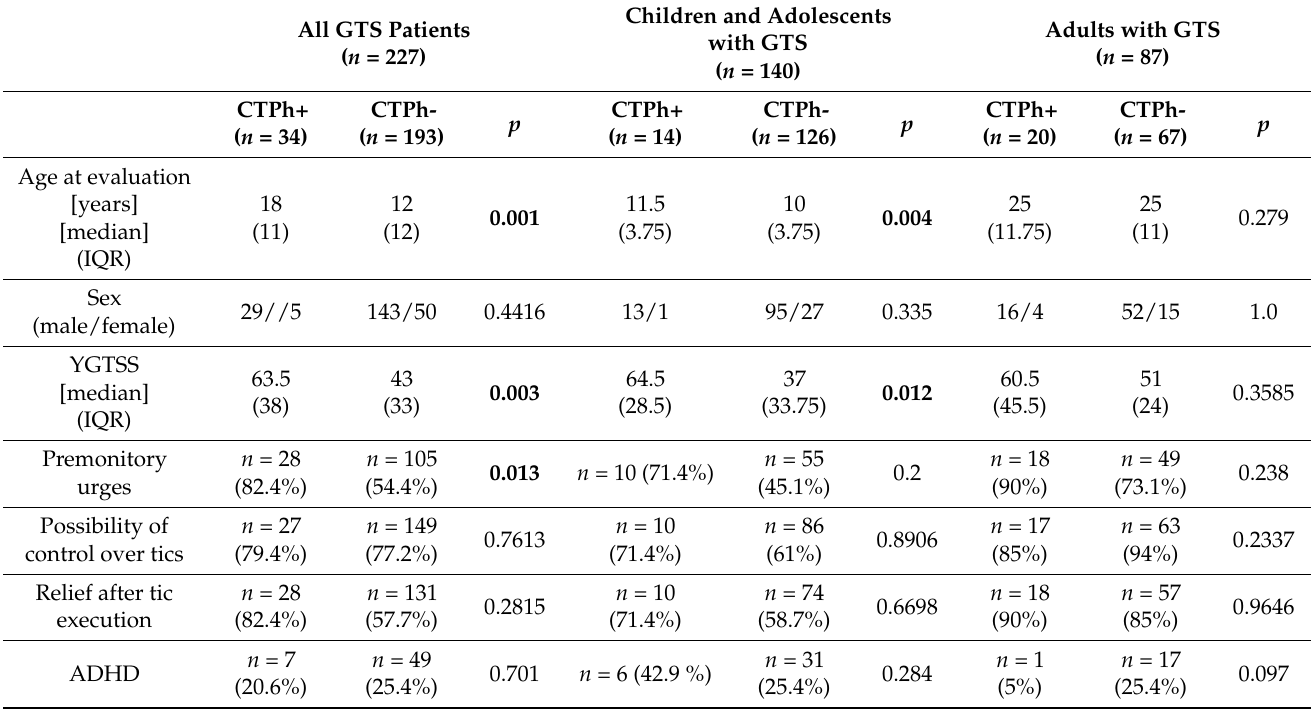
Table 2. Comparison of lifetime CTPh- and CTPh+